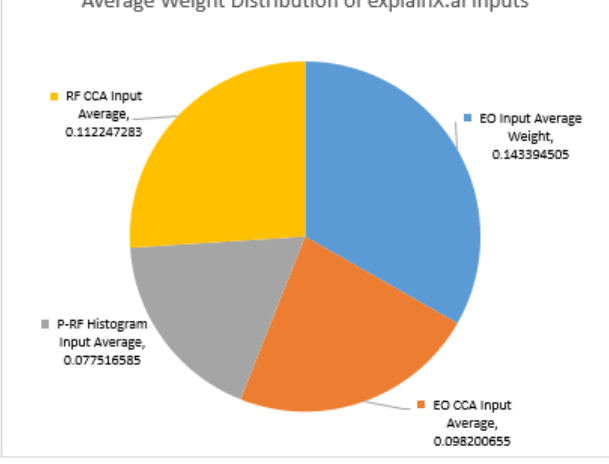
Figure 4. Comparison of average weights for all five targets.